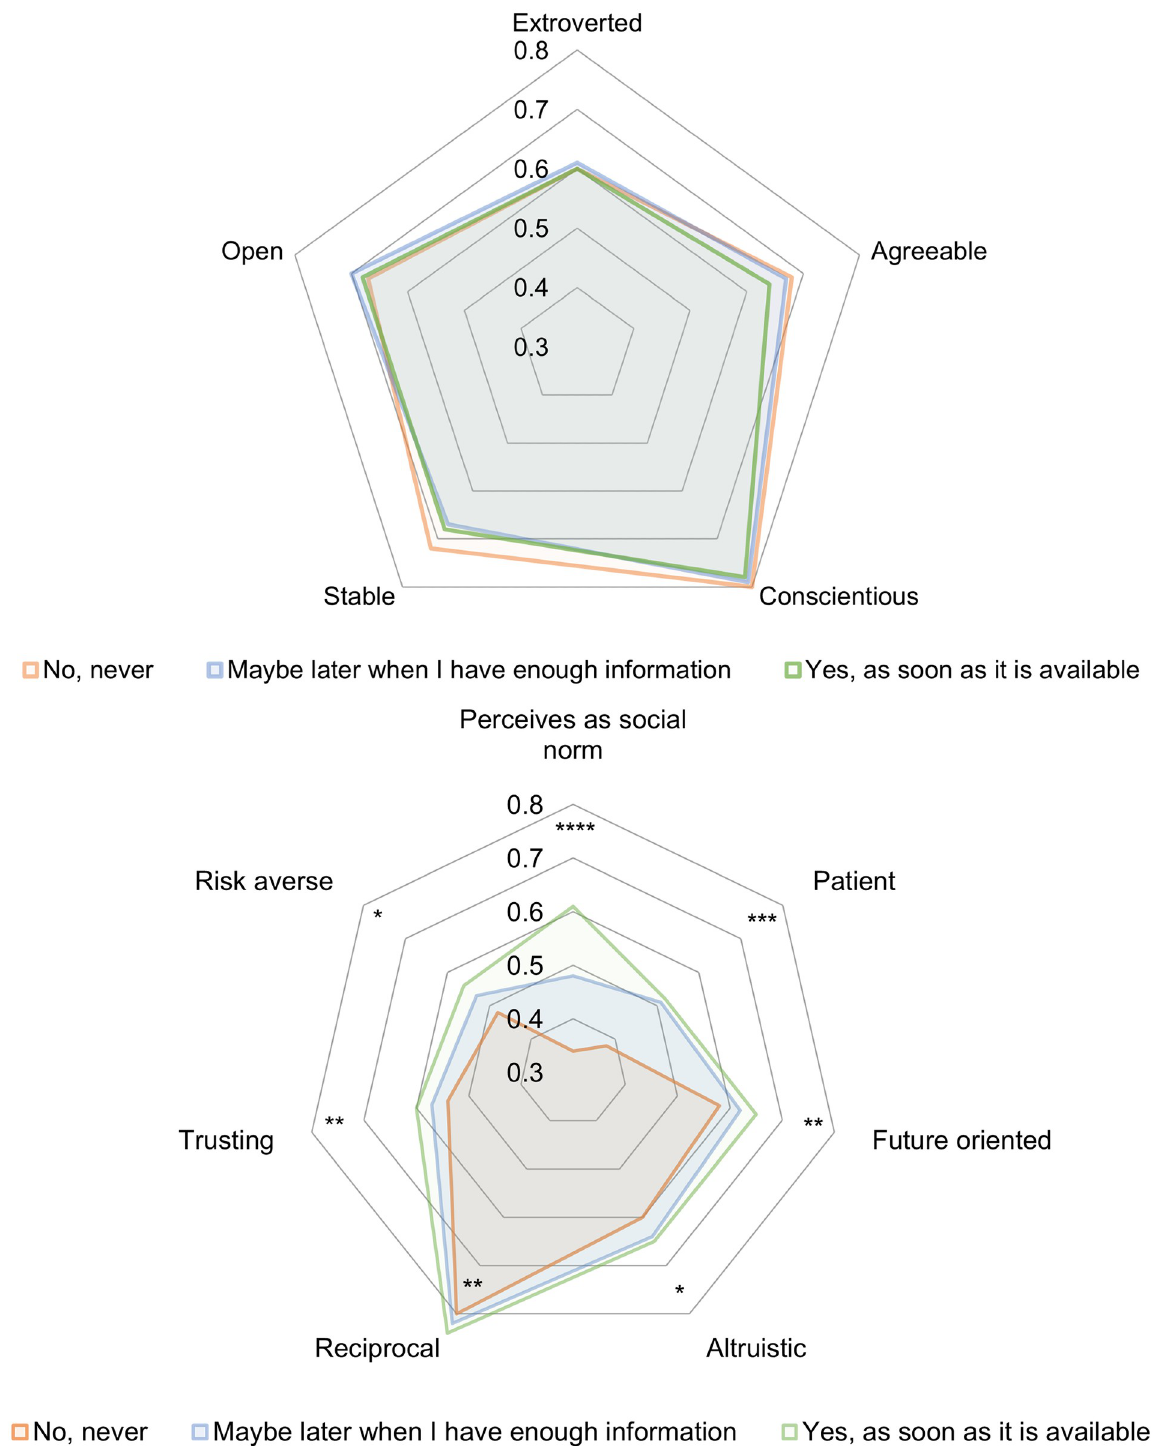
Fig 3. Descriptive statistics of personality traits, preferences and perceived social norm by vaccination willingness. ( a ) Personality traits ( b ) Preferences and perceived social norm. Survey question (n = 915): “Assuming that the COVID-19 vaccination is free of charge and approved in Switzerland, would you like to be vaccinated?” All variables are normalized and range from 0 to 1. For each characteristic, we show the mean value of the respondents within each of the three groups. The statistical differences using two-sided t-tests for independent sub-samples between the “Yes, as soon as it is available” group and the “No, never” group are depicted as follows: � p < 0.1, �� p < 0.05, ��� p < 0.01, ���� p < 0.001.